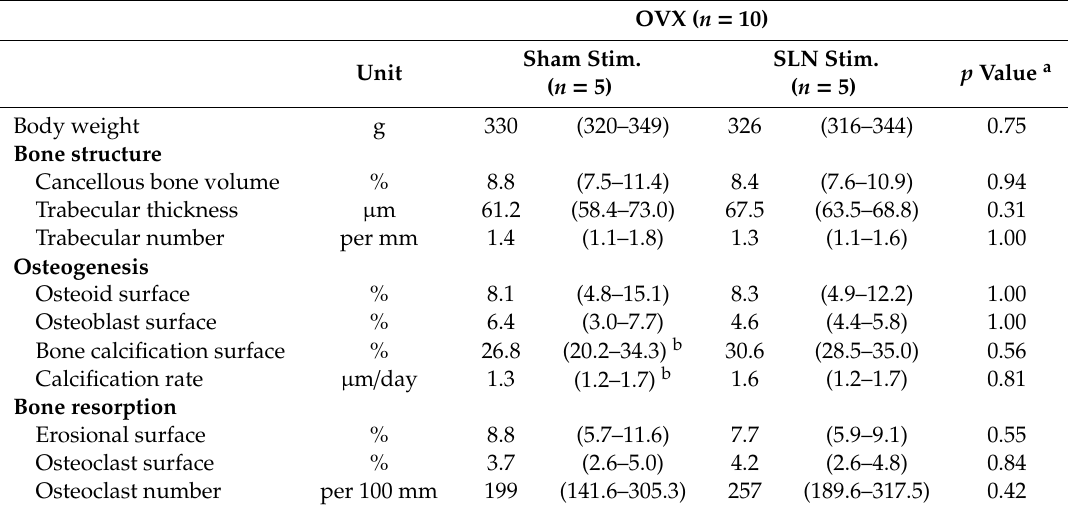
Table 2. E ff ect of SLN stimulation in OVX rats on bone